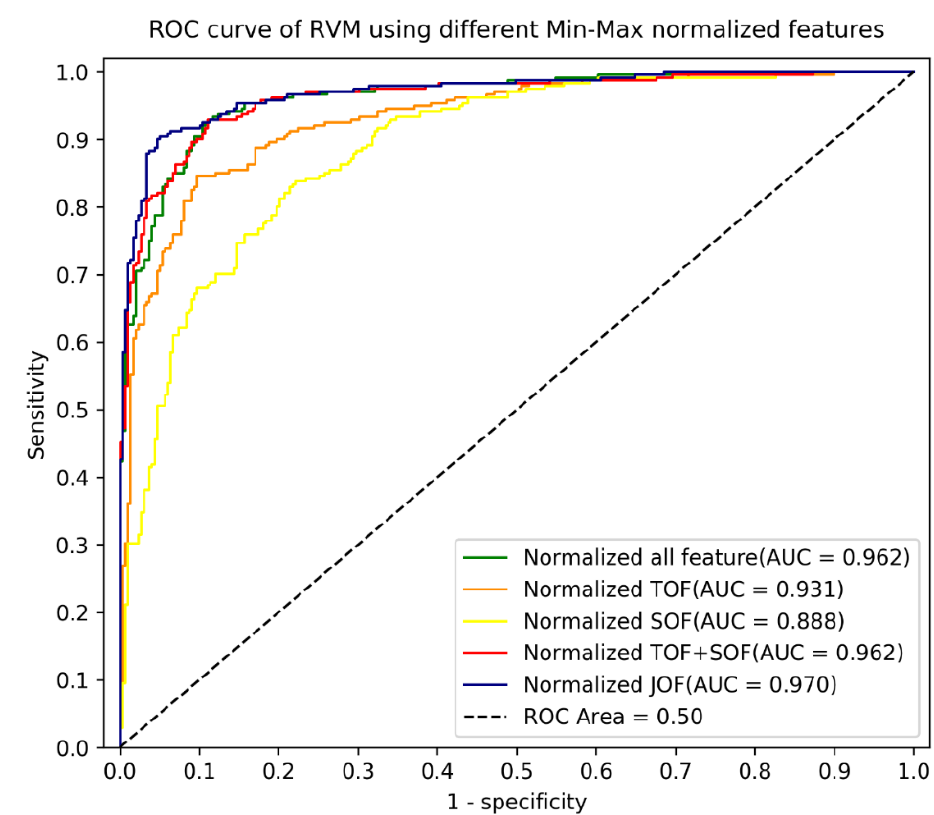
Figure 2. Receiver operating characteristic (ROC) of RVM of normalised, optimised features on validation